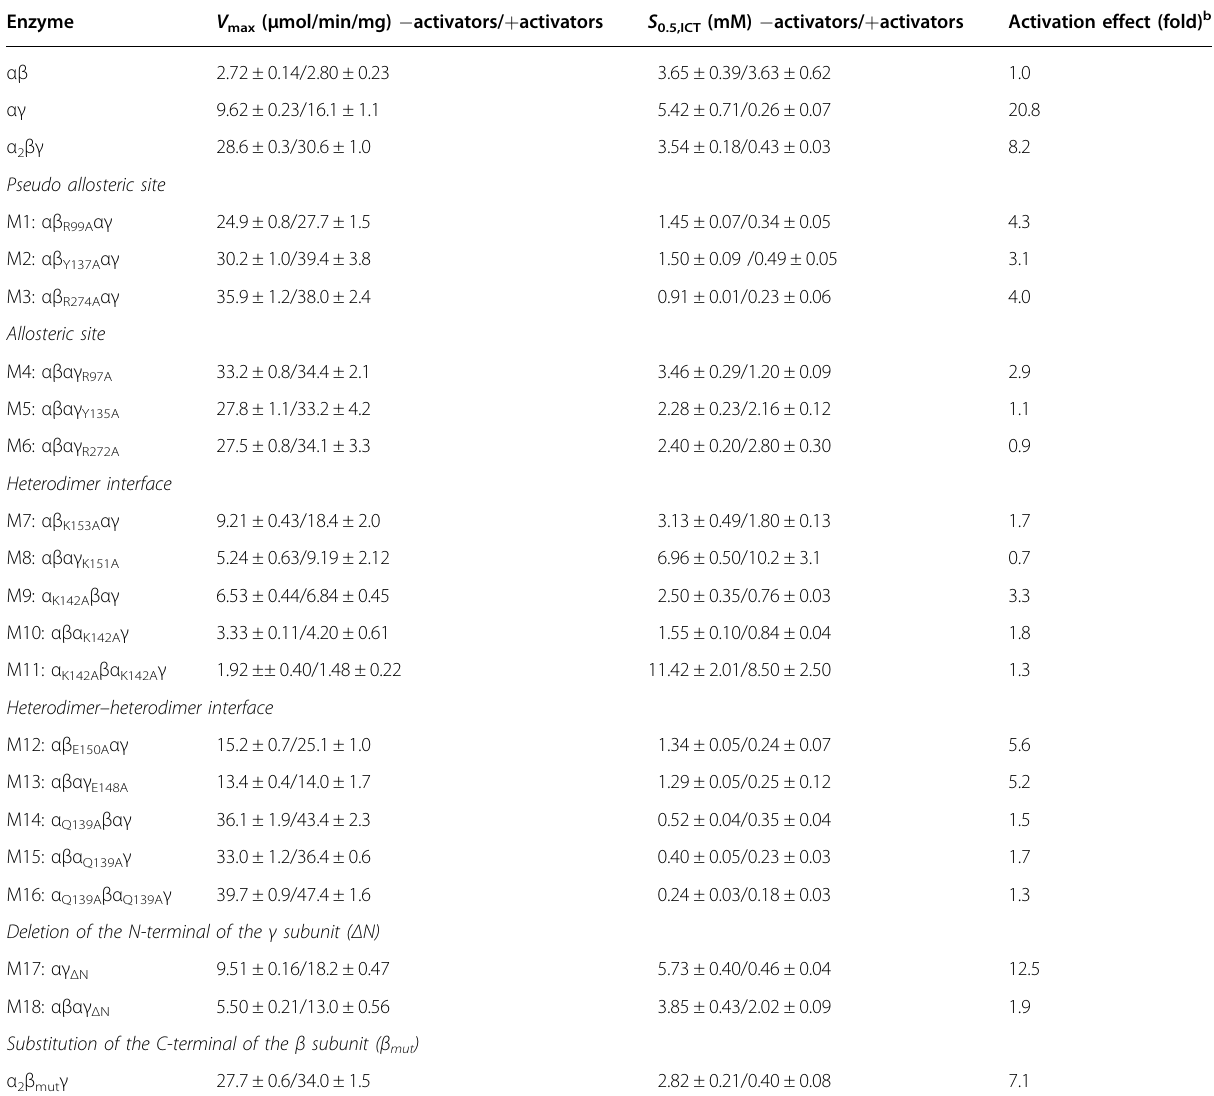
Table 2 Activities and kinetic parameters of the wild-type and mutant HsIDH3 a .